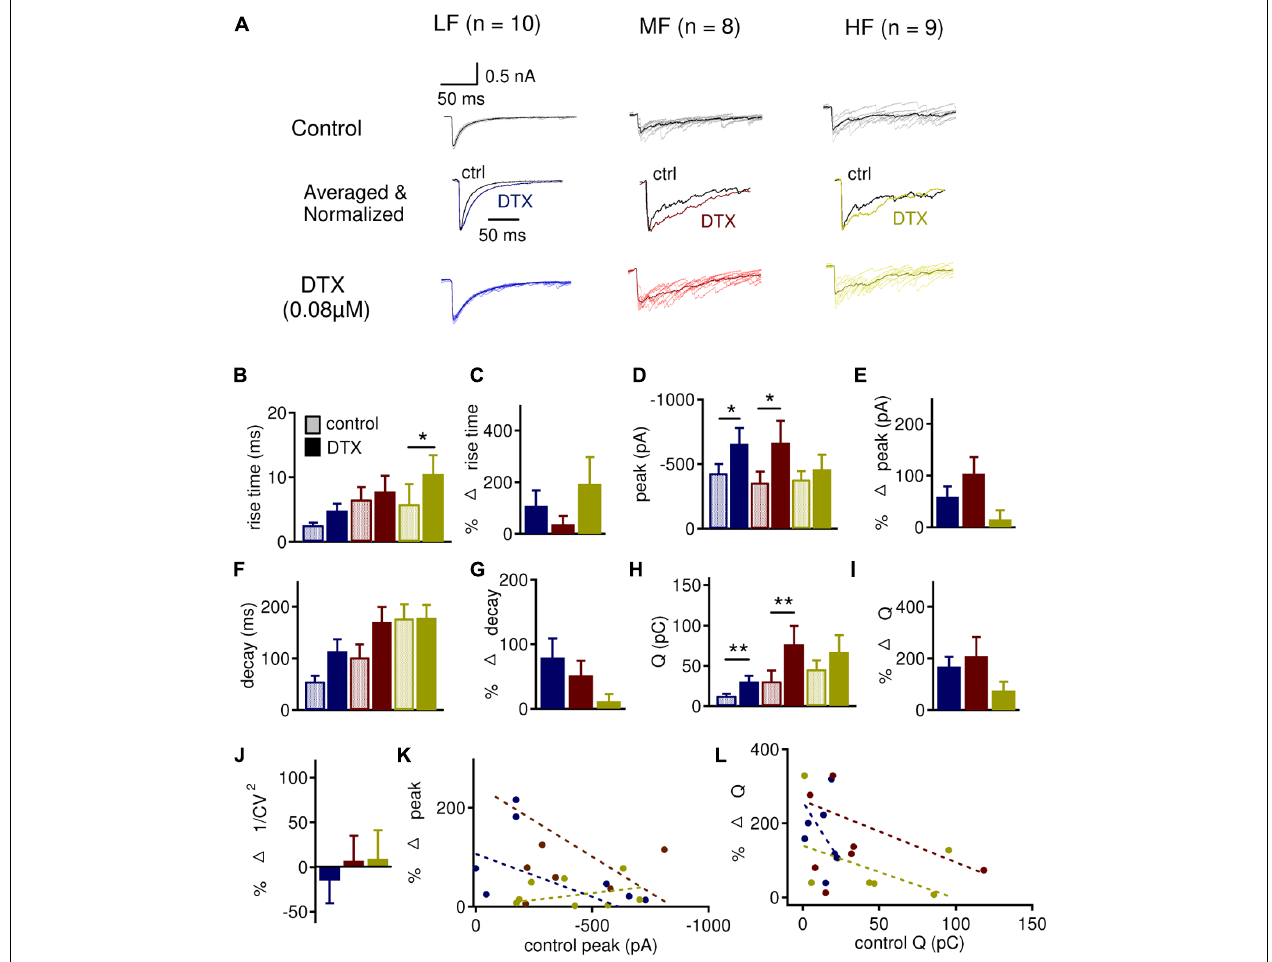
FIGURE 8 | DTX preferentially regulates IPSC frequency and shape in LF and MF neurons. (A) Sample evoked IPSC recordings before (dark traces) and after (color traces) bath application of DXT (0.08 μ M) in LF ( n = 10), MF ( n = 8), and HF ( n = 9) NL neurons. See Figure 6A for legend. (B,C) DTX increases the 10–90% rise time in HF (control: 5.8 ± 3.3 ms, DTX: 10.5 ± 3.1 ms) neurons, but not in LF (control: 2.6 ± 0.4 ms, DTX: 4.8 ± 1.2 ms) and MF (control: 6.1 ± 1.9 ms, DTX: 6.6 ± 2.4 ms) neurons, without significant differences in percent changes across tonotopic axis. (D) DTX increased the IPSC peak amplitude in LF (control: − 429.8 ± 72.6 pA, DTX: − 656.4 ± 112.7 pA) and MF (control: − 357.1 ± 83.3 pA, DTX: − 662.5 ± 172.7 pA) but not in HF (control: − 379.9 ± 66.6 pA, DTX: − 460.4 ± 113.4 pA) neurons. (E) Percent change in IPSC peak amplitude is not significantly different between LF (58.5 ± 20.6%), MF (103.8 ± 32.5%), and HF (15.2 ± 17.4%) neurons. (F) No change in the decay time constant was observed in LF (control: 55.4 ± 10.7 ms, DTX: 113.5 ± 23.7 ms),